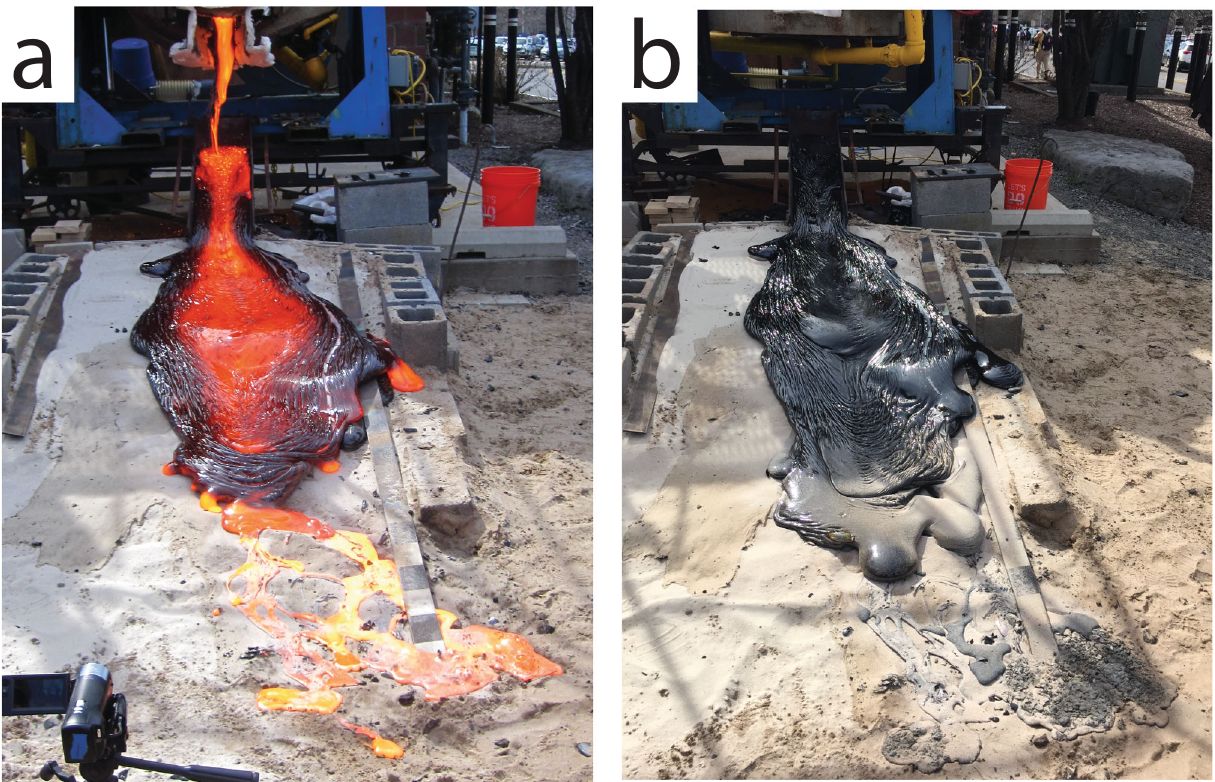
Fig. 2 Flow morphologies. a Syn-emplacement we observe the metallic fl ow (yellow) emerging from underneath the silicate fl ow (orange-black). b Post- emplacement the metallic fl ow appears gray/silver, whereas the silicate fl ow is